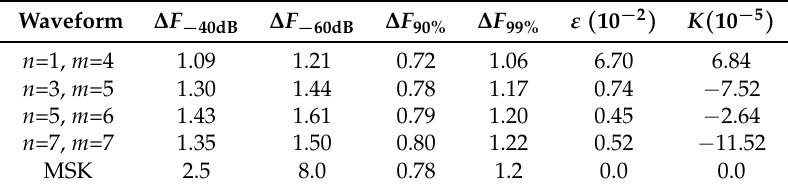
Table 3. Comparison of the characteristics of the signals of the energy spectrum and K . MSK: minimum shift